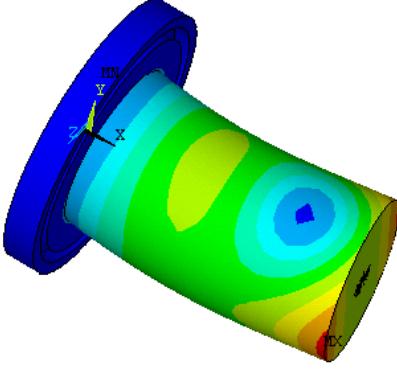
Figure 6. Vibration mode shape of cylindrical horn at frequency of 38.198 kHz.